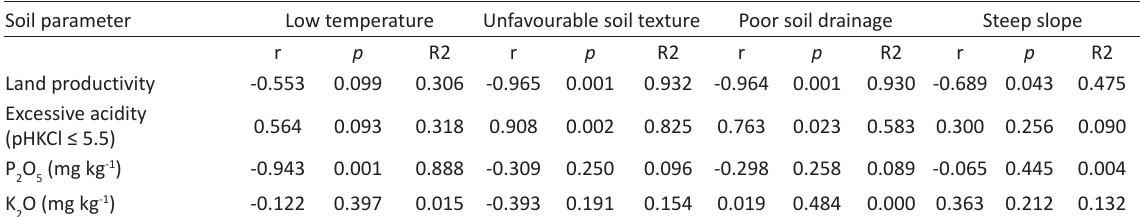
Table 7. Correlation (r) and determinant (R2) coefficients between the natural handicap criteria and basic parameters of soil Soil